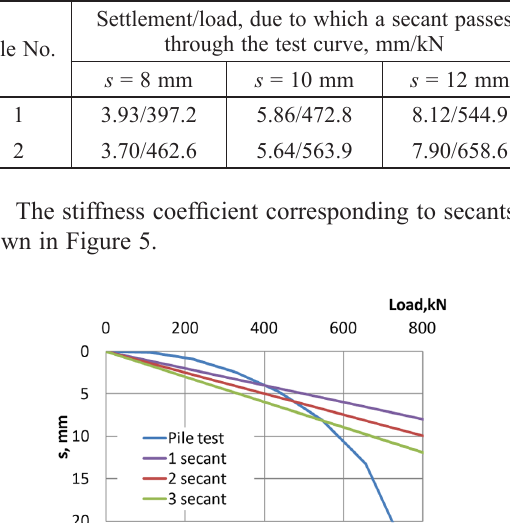
Table 3. Secant passes through the test curve